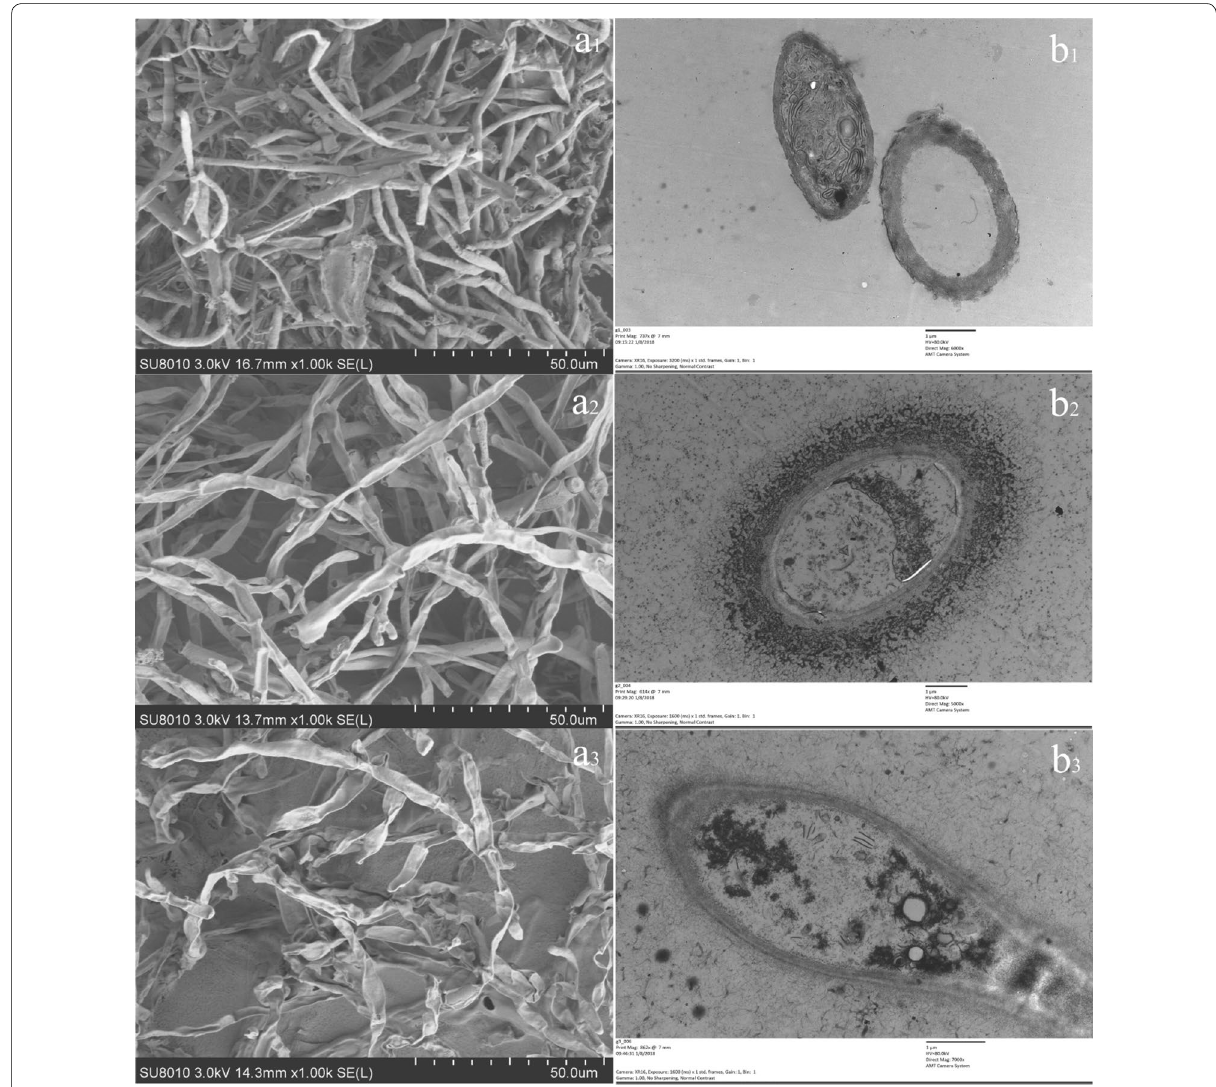
Fig. 2 Electron microscope detection of C. gloeosporioides . The images on the left side of the figure show scanning electron micrographs of C. gloeosporioides and the images on the right side show transmission electron micrographs. a1 and b1 are the images from the blank control group, a2 and b2 are images from the 2,4-di- tert -butylphenol treatment, a3 and b3 are the images from the CF-3 24hFB